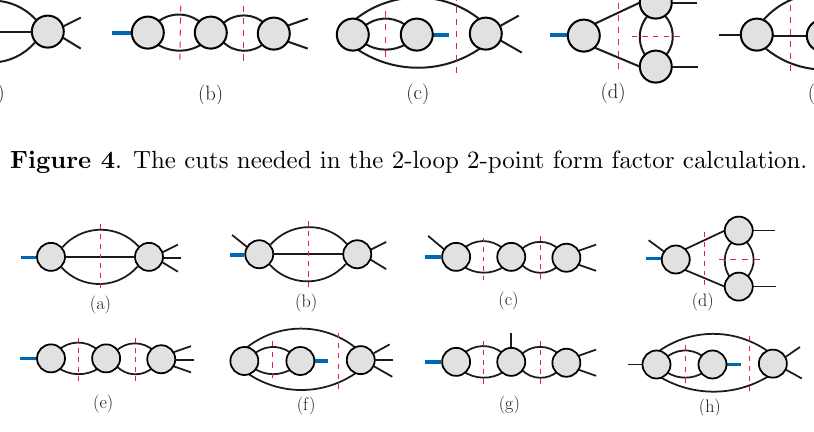
Figure 5 . The cuts needed in the 2-loop 3-point form factor calculation.